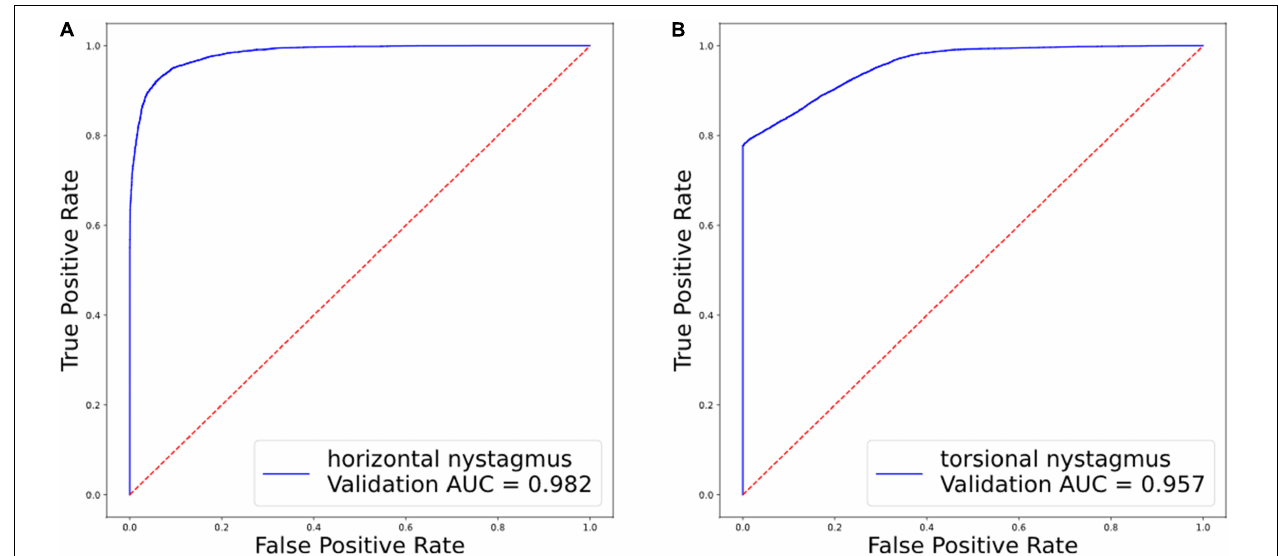
FIGURE 7 | Model performance. The receiver operating characteristic curve (ROC) of model performance classifying nystagmus types after model training. (A) The area under the ROC for measuring horizontal nystagmus is 0.982. (B) The area under the ROC for measuring torsional nystagmus is 0.957.